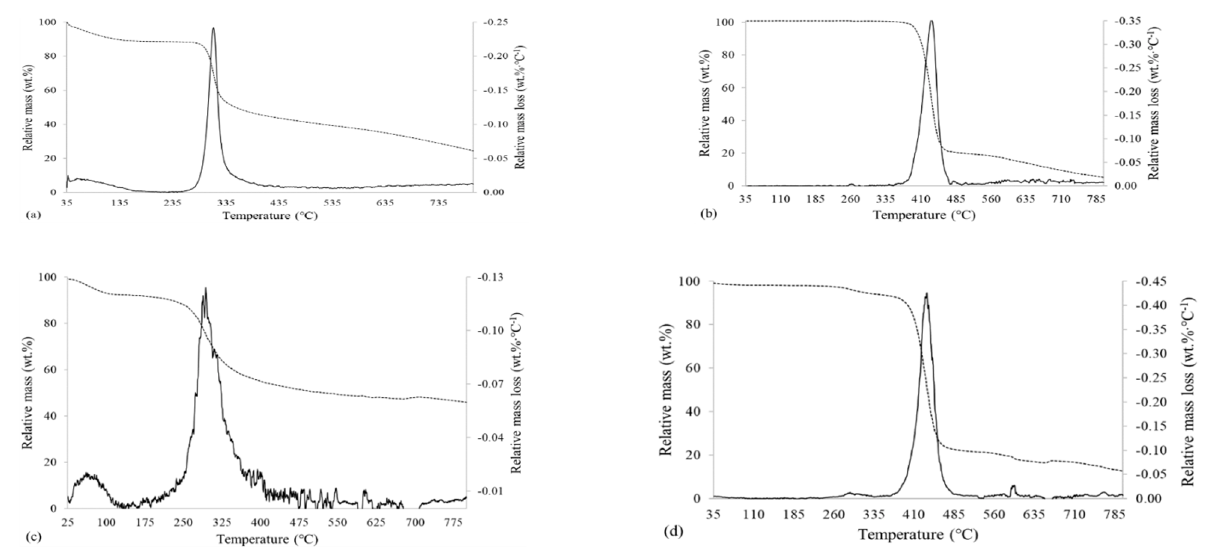
Figure 2. TGA (dashed line) and DTG (solid line) curves for chitosan ( a ), PET layer ( b ), non-supported membrane ( c ), and PET-supported membrane ( d ).